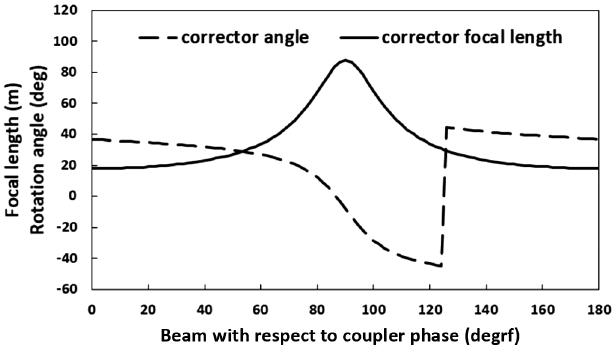
10. The correction quadrupole rotation angle (dashed line) and focal length (solid line) vs the beam to coupler rf phase for a high-power coupler of a SRF linac. The corrector rotation angle is discontinuous near the coupler phase of ∼ 125 degrf where the denominator of Eq. (50) is zero and the 1 tan − 1 function jumps to 2 stay within its principal value range of − 45 ° and FIG. 11. LCLS-II injector emittance evolution with a perfect rf field (blue line), with 3D rf coupler fields (green line), and emittance cancellation using a weak (0.9 G) rotated ( − 17 . 2 °) correction quadrupole (red line) for 300